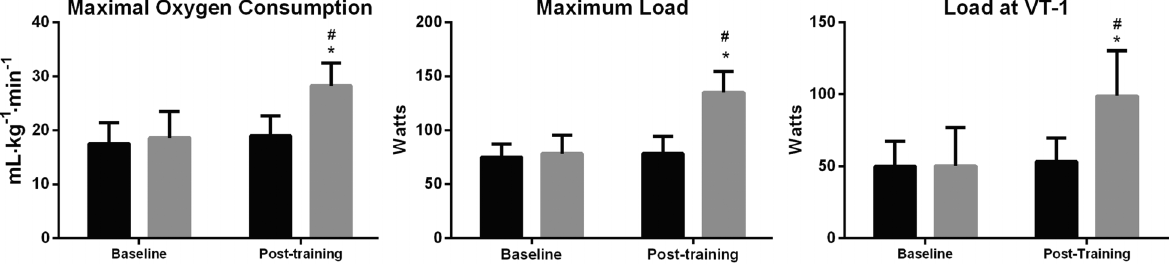
Figure 3. Parameters of physical fi tness testing. Control group: black bars; Experimental group: gray bars. Data are reported as means ± SD. *P p 0.05 compared to baseline; # P p 0.05 compared to control group (two-way repeated measures ANOVA with a Duncan post hoc